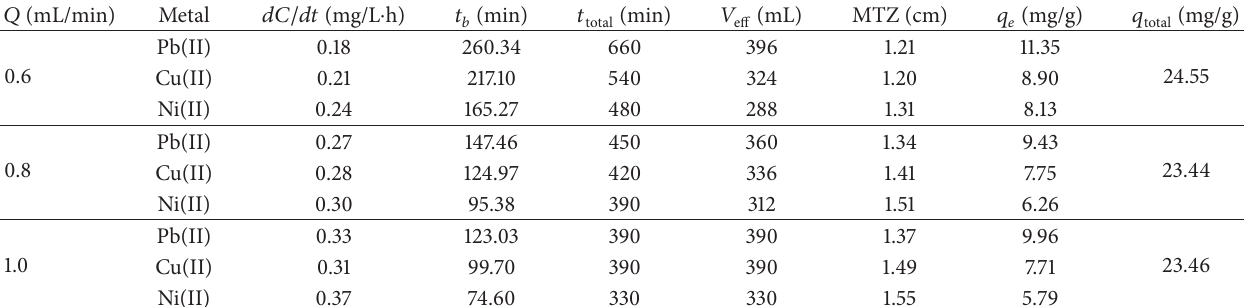
Table 2: Column adsorption data and parameters of ternary metal solution of Pb(II), Cu(II), and Ni(II) at different solution flow rates with initial metal concentration of 100mg/L and bed height of 2.0 cm.